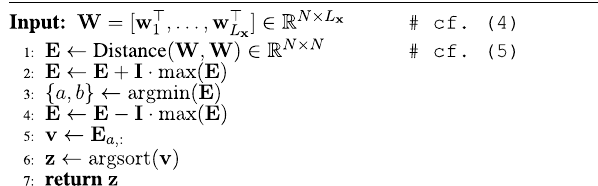
Algorithm 1. Channel sorting algorithm.